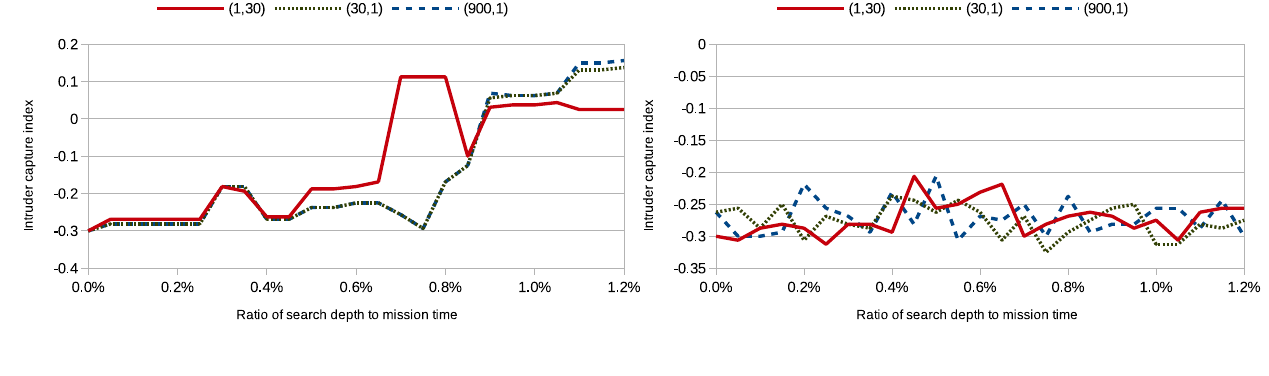
Figure 5. Intruder capture index for Scenario B1 using uavsAction () ( left ) and localSearch () ( right ).